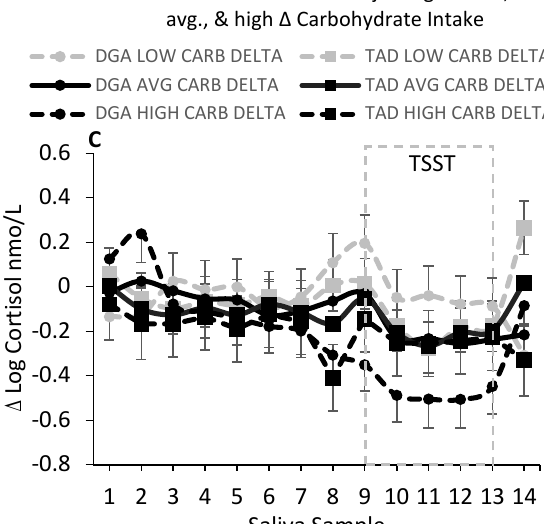
Figure 1. ( A ) shows salivary cortisol (nmol/L) at baseline (pre-intervention test week 1) and week 9 for each diet group at each time point from waking (sample 1) to bedtime (sample 14). There were no statistical differences in salivary cortisol between the diet groups (DGA, N = 22; TAD, N = 21). However, when accounting for inter-individual differences between the pre-intervention (“habitual”) diet and the intervention diet, there was a significant ( P = 0.0001) interaction between diet group, week, saliva sample, and magnitude of change in carbohydrate intake from habitual to the intervention level of intake. The significant ( P = 0.0001) interaction between diet group, week, saliva sample, and level of change in carbohydrate intake was reflected primarily by a reduction in salivary cortisol just prior to the stress test (Trier Social Stress Test; TSST) and up to 120 minutes post-stress in the DGA (Dietary Guidelines for Americans ） group that also had the highest increase (90 th percentile) in carbohydrate consumption from the pre-intervention to the intervention period. ( B ) Salivary cortisol (nmol/L) at baseline and week 9 for each diet group at the highest increase (90 th percentile) in carbohydrate consumption from the pre-intervention (habitual) to the intervention period. ( C ) The 8-week change ( ) in salivary cortisol concentration (nmol/L). There was a significant ( P = 0.0001) interaction between diet group, saliva sample, and level of change in total carbohydrate intake for the 8-week change ( ) in salivary cortisol concentration. A low increase in CARB (total carbohydrate; +166 grams) was taken as the 10 th percentile increase in carbohydrate consumption from the pre-intervention to the intervention period; an AVG (average; middle 90 th percentile) increase in carbohydrate (+224 grams) was taken as the mean level increase in carbohydrate consumption from the pre-intervention to the intervention period; and a high increase in CARB was taken as the 90 th percentile increase in carbohydrate (+305 grams) from the pre-intervention to the intervention period. Baseline age, education, body mass index (BMI), and hunger score from the Three-Factor Eating Questionnaire were included as independent variables in all of the statistical models. For visual clarity, data shown in Figure 1A and 1B are adjusted means (least-square means; LSMEANS) only. For Figure 1C, LSMEANS ± s.e. are presented. Table 1. * Slope estimates for association between log salivary cortisol concentration and carbohydrate.